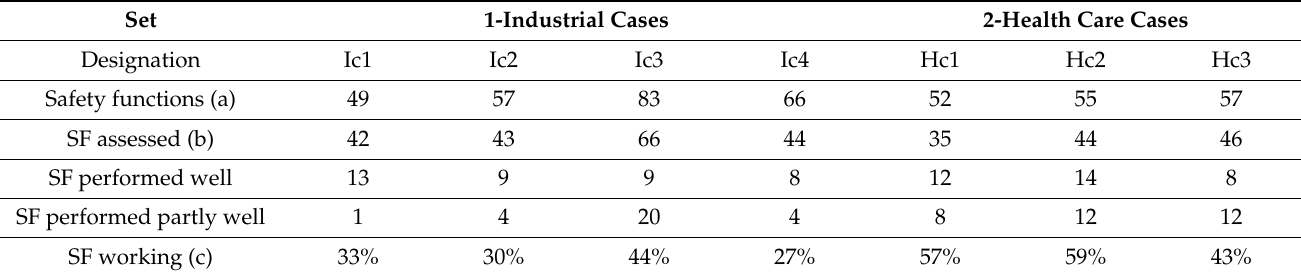
Table 7. Safety functions (SFs) in event investigations with the combined method